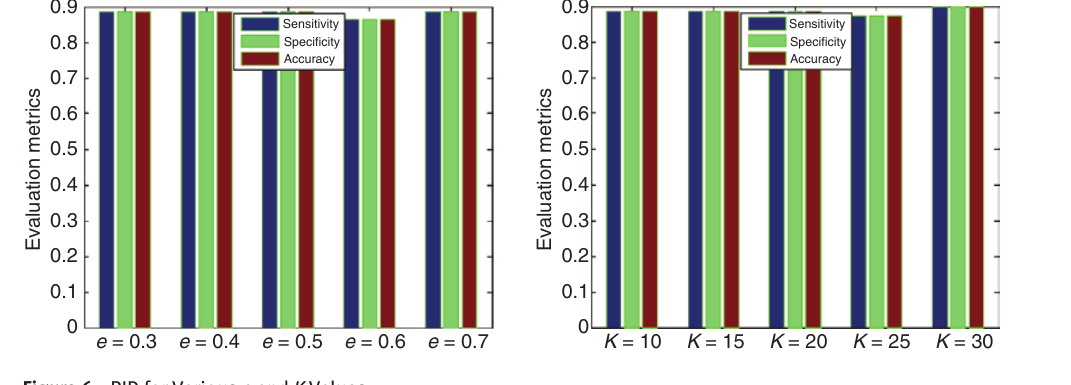
Figure 6: PID for Various e and K Values